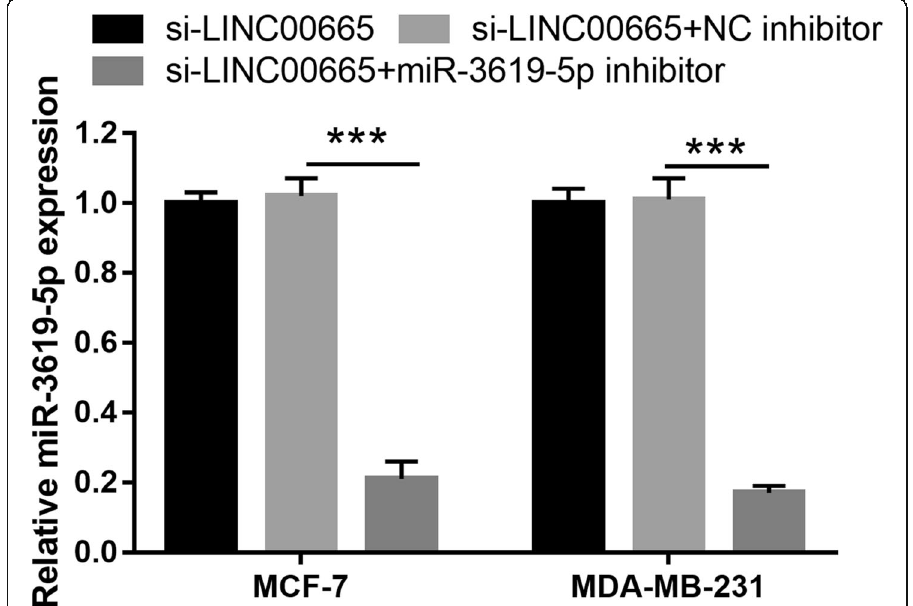
Fig. 6 miR-3619-5p expression was significantly inhibited after simultaneous transfection of the si- LINC00665 plasmid and the miR-3619-5p inhibitor. miR-3619-5p expression, as measured by quantitative reverse transcription-polymerase chain reaction (qRT-PCR) after simultaneous transfection of the si-